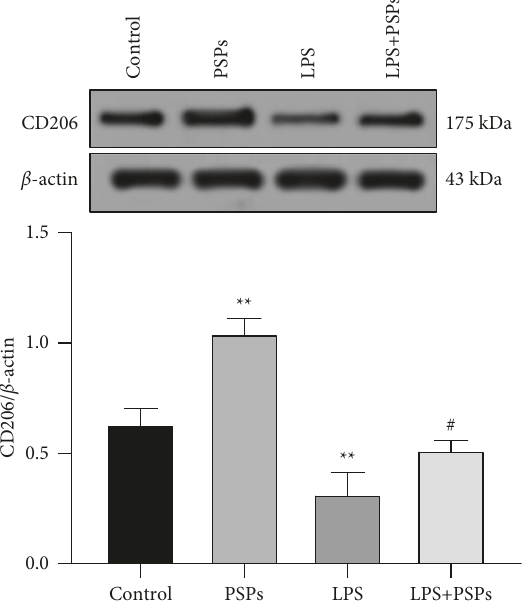
Figure 4: The effect of PSPs on RAW264.7 cells on the secretion of inflammatory factors. ### P 0 . 001, compared with LPS group. <